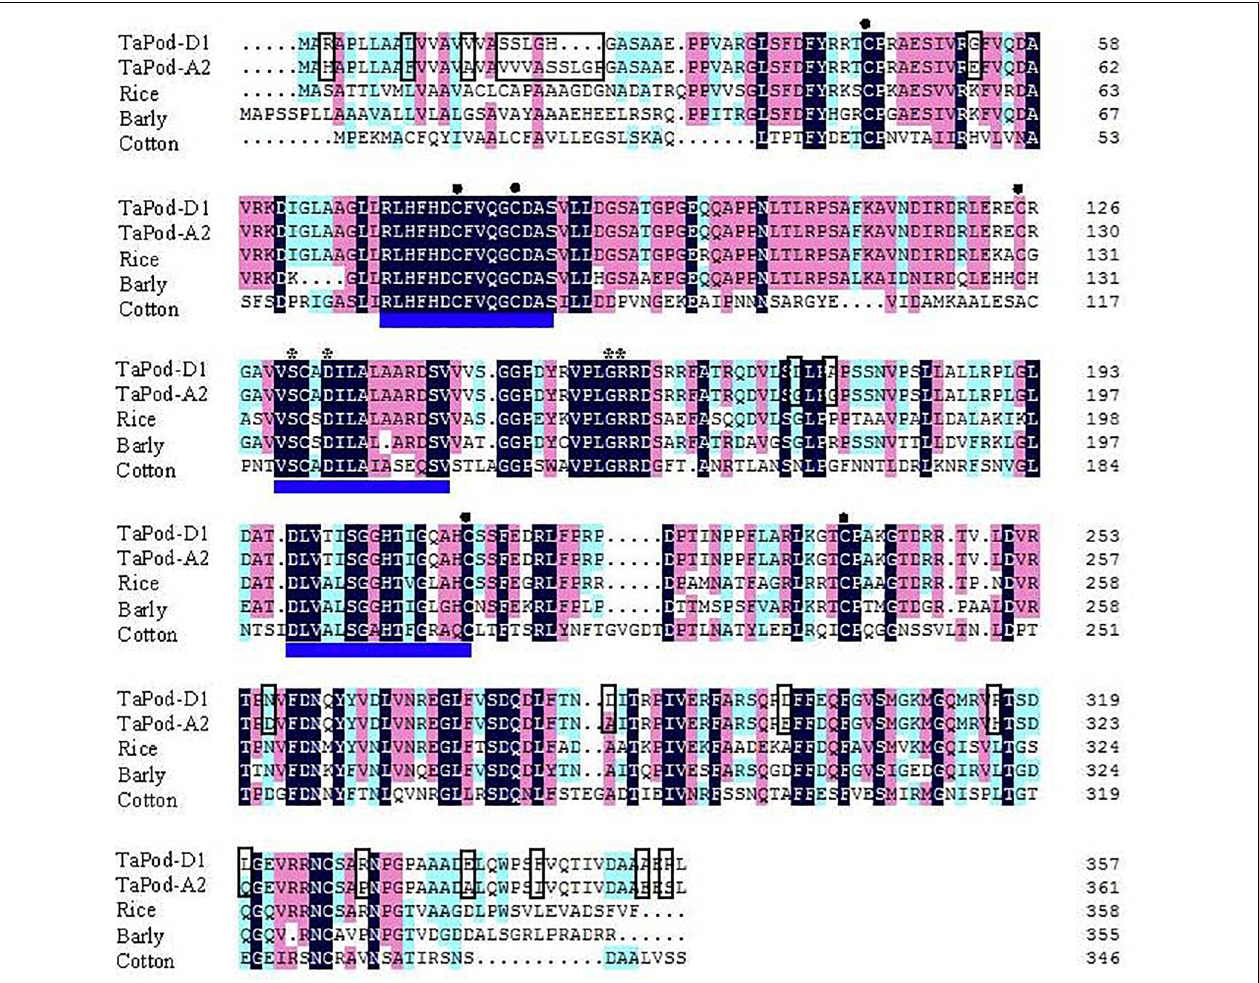
FIGURE 2 | Amino acid sequence alignment of wheat TaPod-A2 and TaPod-D1 , rice (CAH69265), barley (AAA32974), and cotton (AAL92037). The shadows show the same amino acid residues. The different amino acids in the peptide sequences encoded by TaPod-A2 and TaPod-D1 are in boxes. The three conserved domains of class III peroxidase are underlined . The residues involved in a salt bridge are indicated with asterisks ( ∗ ). The cysteines involved in disulfide bridges are indicated with solid circles ( • ) (Hiraga et al., 2001; Passardi et al., 2004a,b; Marchler-Bauer et al., 2009).